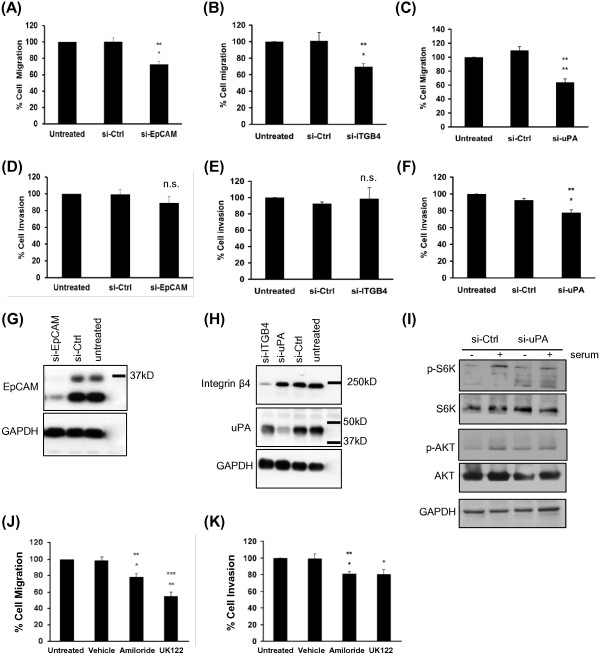
The role of EpCAM, integrin β4 and uPA in migration and invasion of DU145-LN4 cells. Cell migration of DU145-LN4 cells in a transwell migration assay (A-C) and a Matrigel invasion assay (D-F). siRNA knockdown of (A) EpCAM, (B) integrin β4, or (C) uPA significantly inhibited cell migration relative to control siRNA and untreated cells. siRNA knockdown of (D) EpCAM or (E) ITGB4 did not significantly affect cell invasion in a Matrigel invasion assay. (F) uPA siRNA significantly inhibited cell invasion relative to control siRNA and untreated cells. Western blot analysis of whole cell lysates from cells treated with siRNA in parallel with migration/invasion assays: (G) EpCAM, (H) integrin β4, and uPA western blots. Blots were probed with GAPDH as loading controls. (I) Western blot analysis of whole cell lysates from cells treated with control siRNA or si-uPA and serum starved (−) or serum stimulated (+). p-AKT and p-S6K were induced after serum addition in control cells but not in cells lacking uPA. Total AKT, S6K, and GAPDH served as controls. DU145-LN4 cell migration (J), and cell invasion (K) were significantly inhibited by treatment with 10 μM amiloride or 10 μM UK122. Students t-test, *p ≤ 0.05, **p ≤ 0.01, n.s.-not significant. Top asterisked p value represents analysis between untreated cells and specific siRNA, lower value indicates analysis between control siRNA treated cells and specific siRNA.